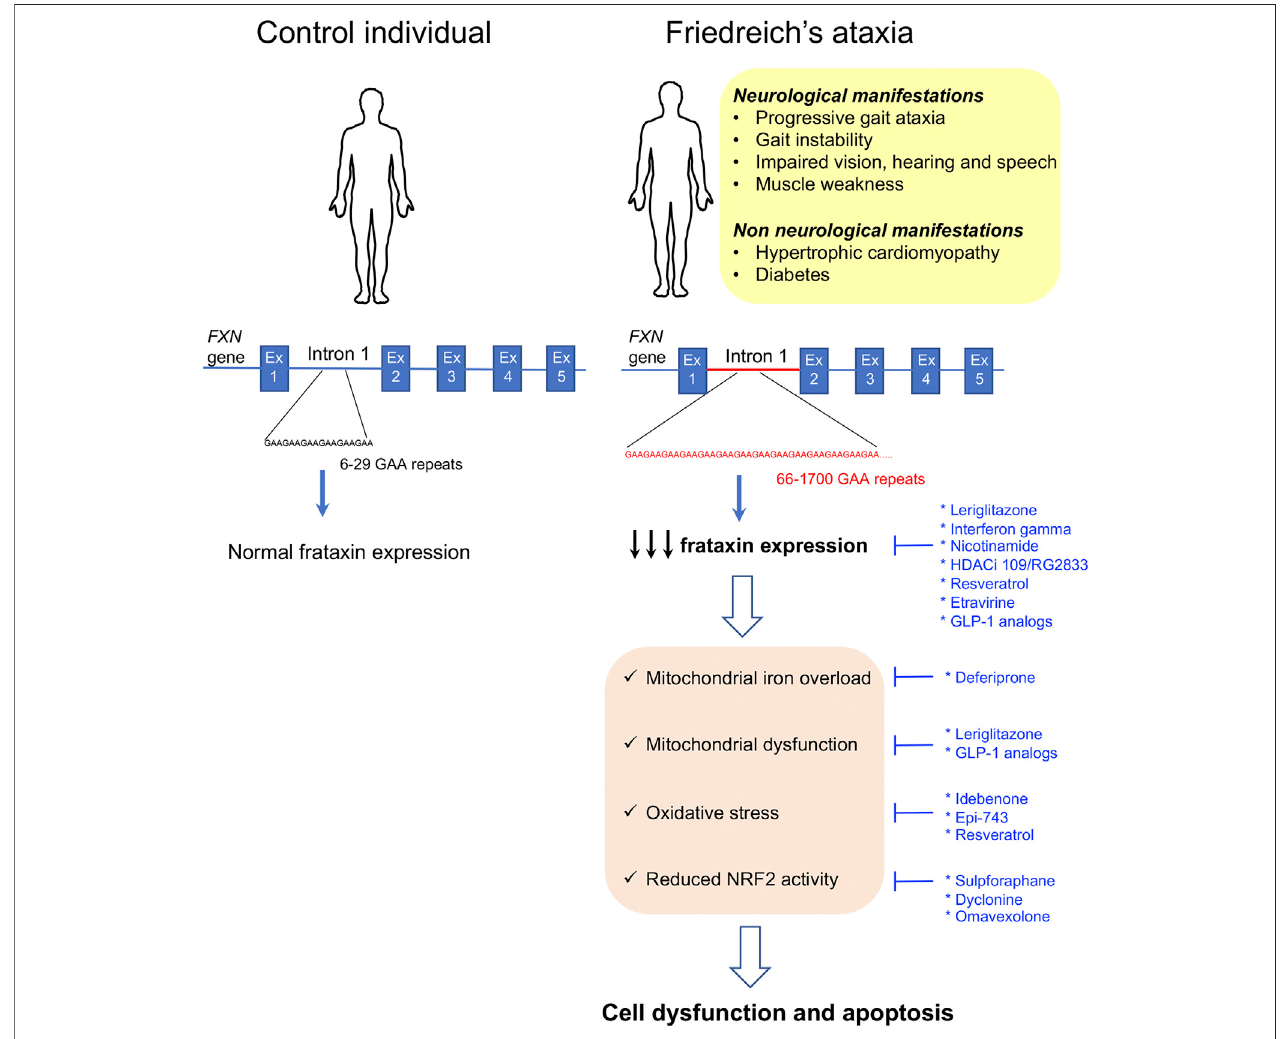
FIGURE2 | Clinical manifestations and moleculardisease mechanisms in Friedreich ’ sataxia.This pathology iscaused byGAA repeat expansions in the fi rst intron of the FXN gene. This results in reduced frataxin protein expression which causes a wide variety ofcellular alterations leading to cell dysfunction and death. Repurposed drugswithandwithoutorphandesignationforFriedreich ’ sataxiaarehighlightedinblue alongwiththecellular dysfunctionsorclinicalmanifestationsthattheytackle. Ex: exon.